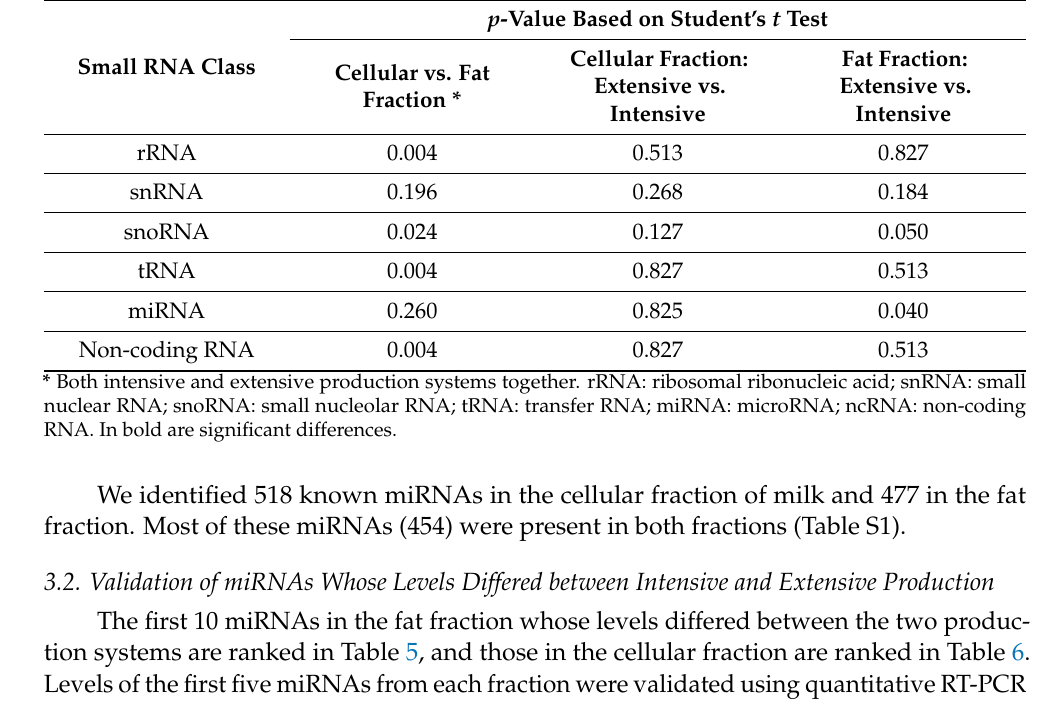
Table 4. Differences in abundance of small RNA classes depending on milk fraction and production